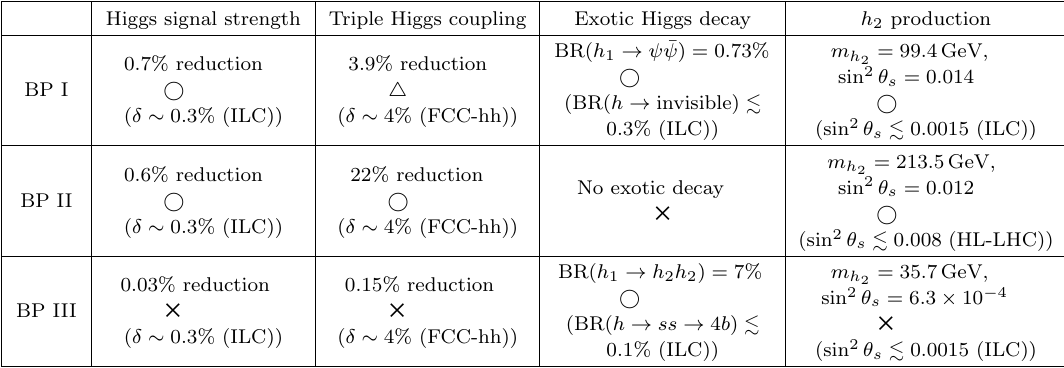
Table 1 . Summary of the collider signatures for the benchmark points. The circle (triangle) denotes that the collider signal of the benchmark can be (marginally) measurable at future colliders. The cases where the collider signal is expected to be hard to measure or beyond the reach of the future colliders are marked with the cross. The texts in parentheses are relevant bounds expected at the future